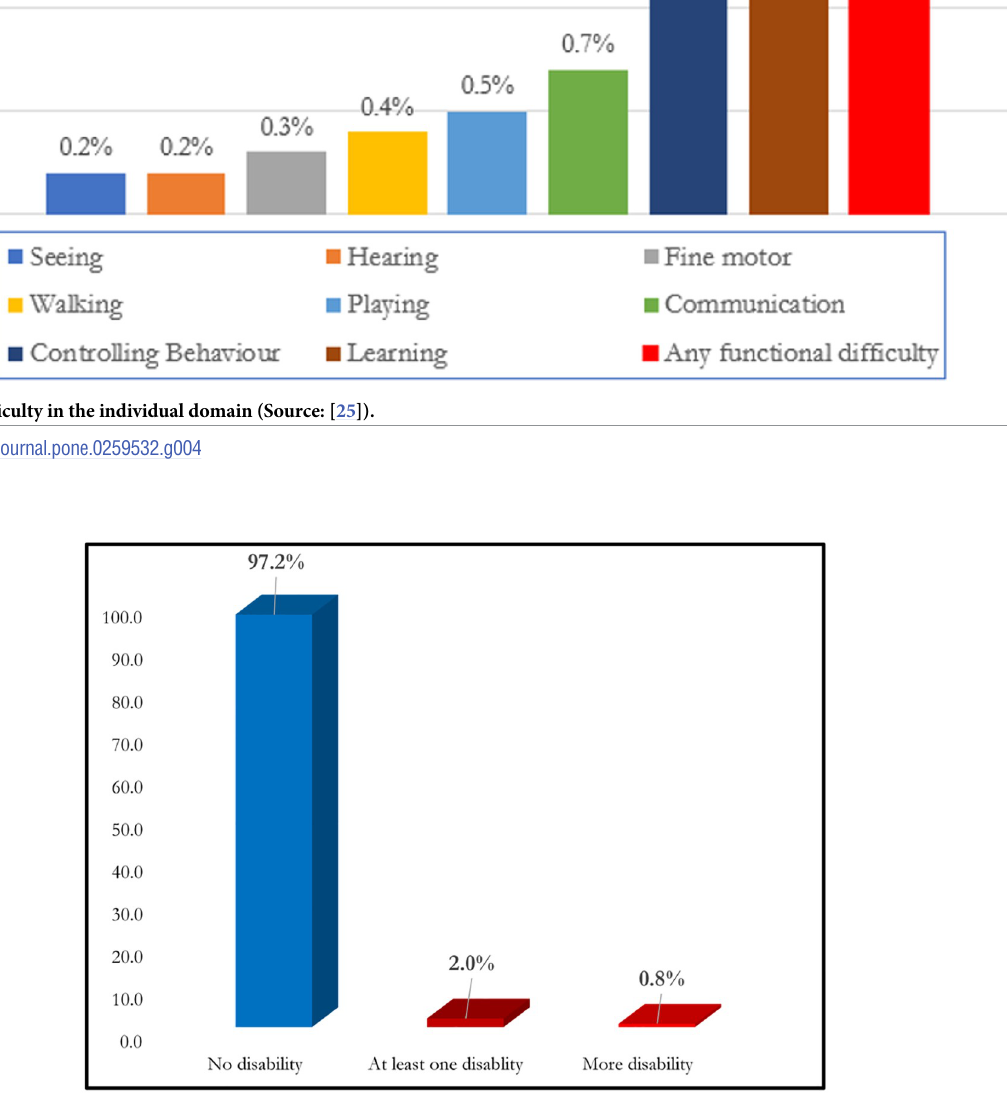
PLOS ONE | https://doi.org/10.1371/journal.pone.0259532 November4,